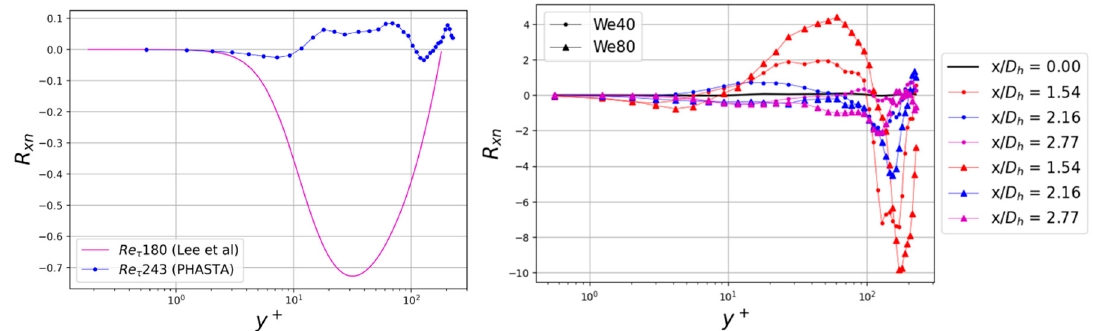
Figure A1. ( Left ) Comparison of normalized crosswise Reynolds stress component ( R xn ) at the inlet cross-section with DNS data from Lee et al. [52]. ( Right ) Downstream evolution of R xn for the two-phase cases (lateral coordinates rotated to 𝑡 − 𝑛 system).